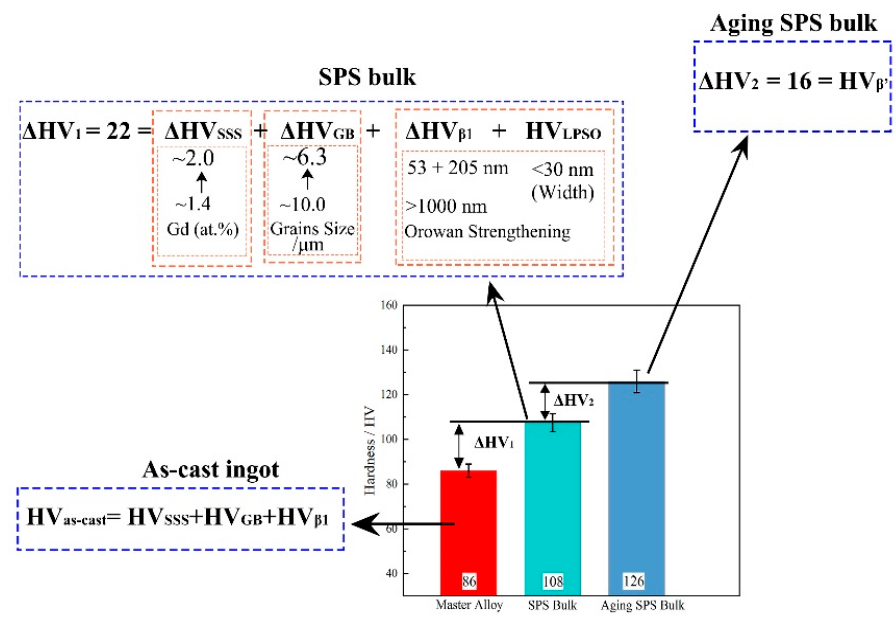
Figure 6. The hardness of Mg 96.9 Gd 2.7 Zn 0.4 alloy under different states and the contributions to HV hardness.